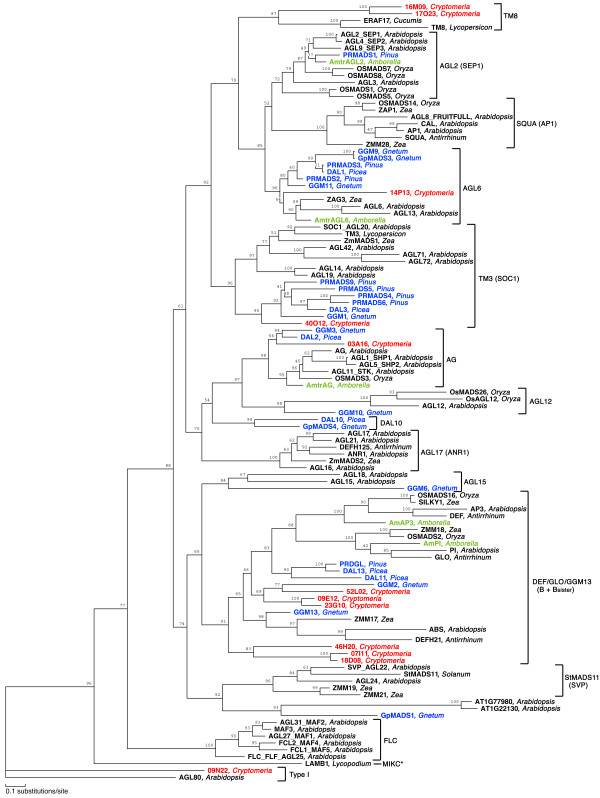
A phylogenetic tree based on MADS, I- and K-domains of deduced proteins. The local bootstrap probability is shown on branches where available. This tree is an unrooted tree. MIKCC-type genes are divided into 13 subfamilies, including gymnosperm-specific DAL10-like subfamily, on the basis of this tree. The genus from which each transcript was isolated is indicated after the deduced protein name. Deduced proteins from C. japonica that were identified in the present study are indicated in red. Deduced proteins from gymnosperms other than C. japonica are indicated in blue, and deduced proteins from basal angiosperms are indicated in green.